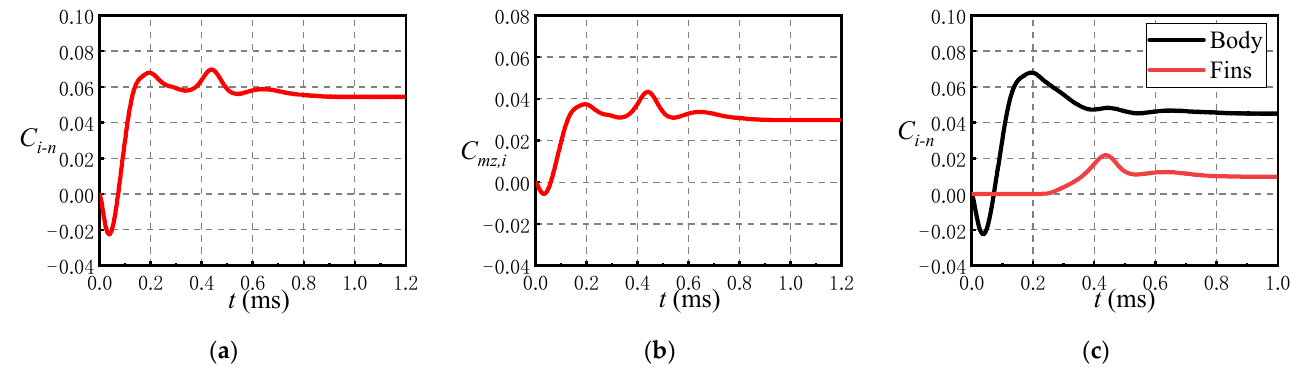
Figure 8. Variation of aerodynamic coefficient with time since lateral jet startup: ( a ) Interference normal force coefficient; ( b ) interference pitching moment coefficient; ( c ) C i-n of different components.